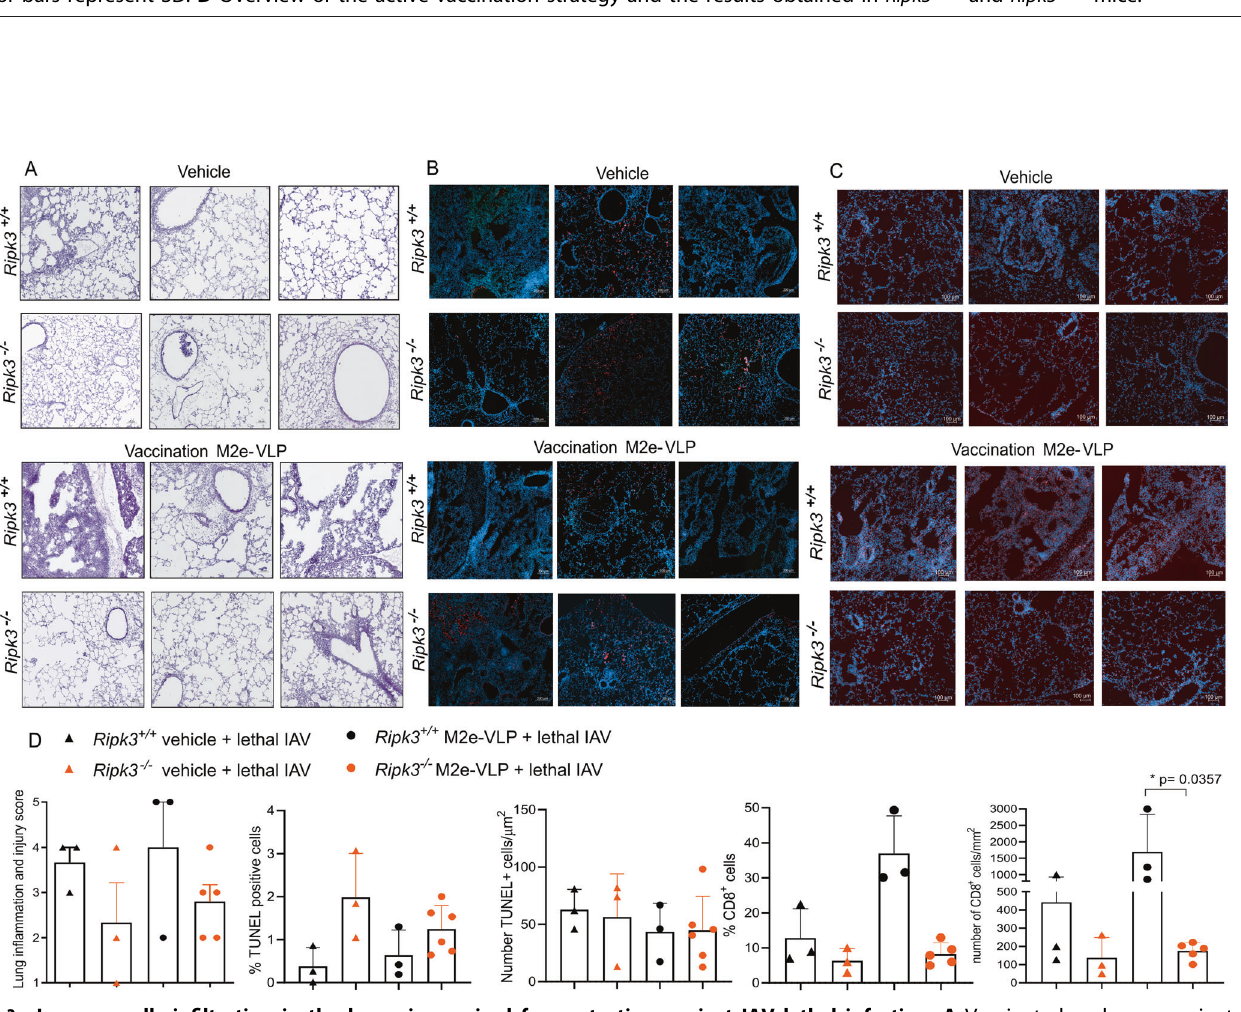
Fig. 1 Ripk3-de fi cient mice are not protected against IAV lethal infection following active vaccination with M2e-VLP despite similar serum levels of M2e-speci fi c antibodies and viral clearance. A Active vaccination with M2e-VLP particles was administered with Alhydrogel ® adjuvant intraperitoneally. Age-matched Ripk3 + / + and Ripk3 − / − mice received either 5 µg/mouse M2e-VLP with Alhydrogel ® adjuvant vaccination or just the Alhydrogel ® adjuvant dissolved in PBS (vehicle) 3 weeks and 6 weeks before infection. Lethal challenge was done with the mouse-adapted in fl uenza X47 with either 2 × LD 50 (virus batch 1) or 0.5 × LD 50 (virus batch 2). The experiment was repeated four times independently and data were pooled. Survival curves were plotted for indicated groups and evaluated statistically according to Kaplan – Meier. A log-rank test veri fi ed signi fi cant differences between Ripk3 + / + and Ripk3 − / − mice post-vaccination; **** p -value< 0.0001 (GraphPad Prism 8). Similar numbers of female and male mice were used comparing both genotypes (19 females, 3 males Ripk3 + / + versus 21 females, 6 males Ripk3 − / − ). The body weight readout of this experiment is provided in Supplementary Fig. 2A. B RIPK3-de fi cient mice effectively produce speci fi c antibodies against M2e: Age-matched Ripk3 + / + and Ripk3 − / − mice were primed (6 weeks before infection) then immunized (3 weeks before infection) 10 μ g M2e-VLP with Alhydrogel ® adjuvant or received PBS with Alhydrogel ® adjuvant (vehicle). Serum samples were prepared two weeks after each immunization. Titers of IgG1 IgG2a IgG2b and total IgG against M2e were measured after the immunization were determined by ELISA. The legend shows the M2e-speci fi c antibody titers obtained for individual mice (dots) of each group from three independent experiments. C Virus clearance from the lungs post vaccination is independent from RIPK3-de fi ciency: On day 6 post-infection, lungs were harvested and lung homogenates were assessed for viral titers by TCID 50 . Data for pooled lung homogenates from different mice (two independent experiments) of the same group are shown. The means for TCID 50 are shown for each group as indicated in the legend. Error bars represent SD. D Overview of the active vaccination strategy and the results obtained in Ripk3 + / + and Ripk3 − / − mice.